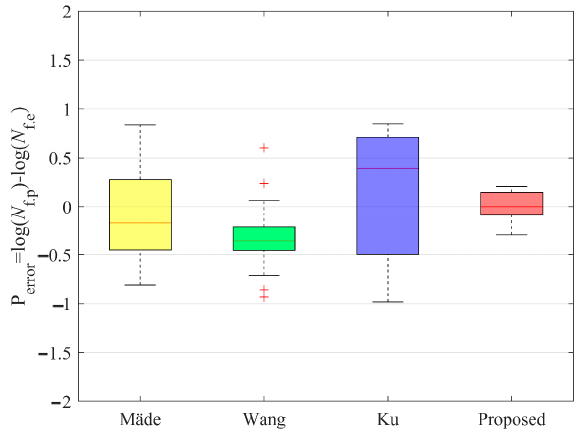
Figure 11. Box plot of model prediction errors.